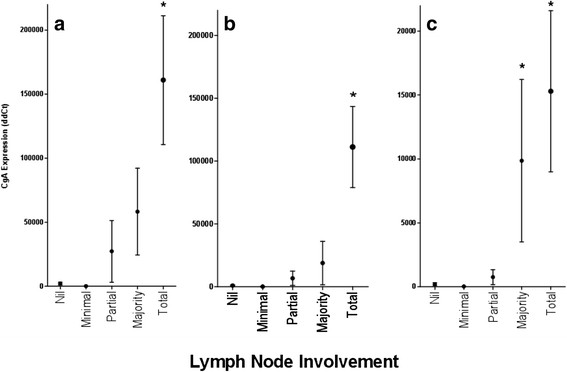
Chromogranin A transcript expression level of and degree of lymph node involvement by tumor. The mean (and SEM) expression level of 3 different CgA primers, namely CHGA Hs00900369_s1 (2a), CHGA Hs00900371_s1 (2b), and CHGA Hs00900373_s1 (2c) is shown. The expression level of CgA differs significantly in all three primers (p < .0001, p = .0004 and p < .0001 respectively). Post-hoc testing shows significantly higher expression in the ‘total replacement’ group than in the ‘nil’ or ‘minimal tumor’ groups for all primers. In addition, post hoc tests show a significant difference between ‘Nil’ and ‘partial replacement’ in the primer shown in 2c.